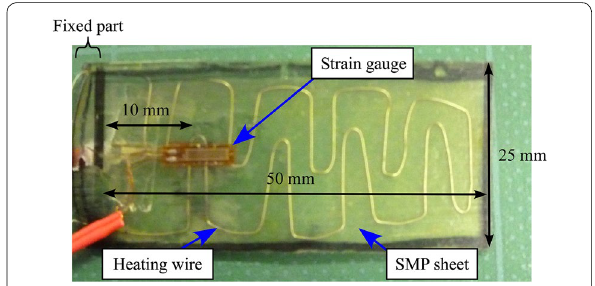
Fig. 2 First prototype force sensor using an SMP sheet with embed- ded electrical heating wire. In order to measure the surface strain of the SMP sheet, two strain gauges were bonded on each side of the SMP sheet